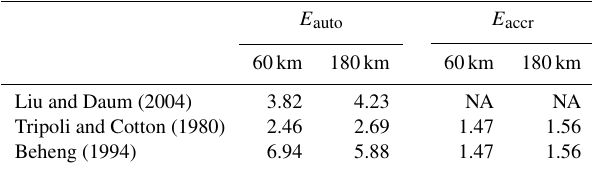
Table 3. Autoconversion and accretion enhancement factors ( E auto and E accr ) for the parameterizations in Table 1, except for the Khairoutdinov and Kogan (2000) scheme. The values are averaged for 60 and 180km equivalent sizes. NA – not